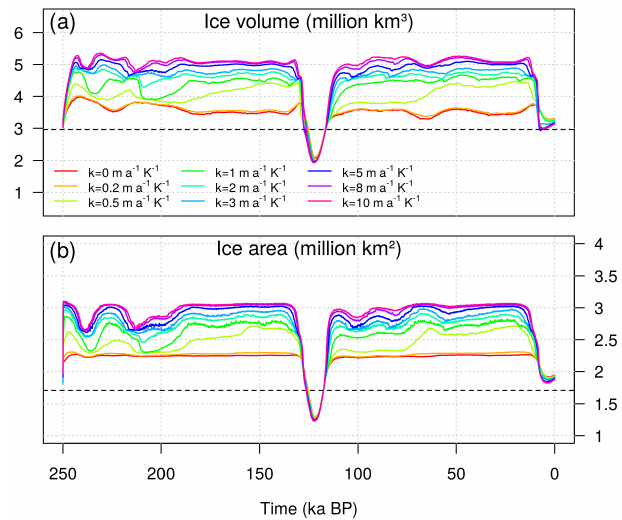
Figure 5. (a) Time evolution of GrIS grounded ice volume (million km 3 ) and (b) ice area (millionkm 2 ) simulated for differ- ent values of the heat-flux coefficient κ , having set B ref = 1ma − 1 . Dashed lines shows the GrIS ice volume and area estimated for the present day (Bamber et al.,